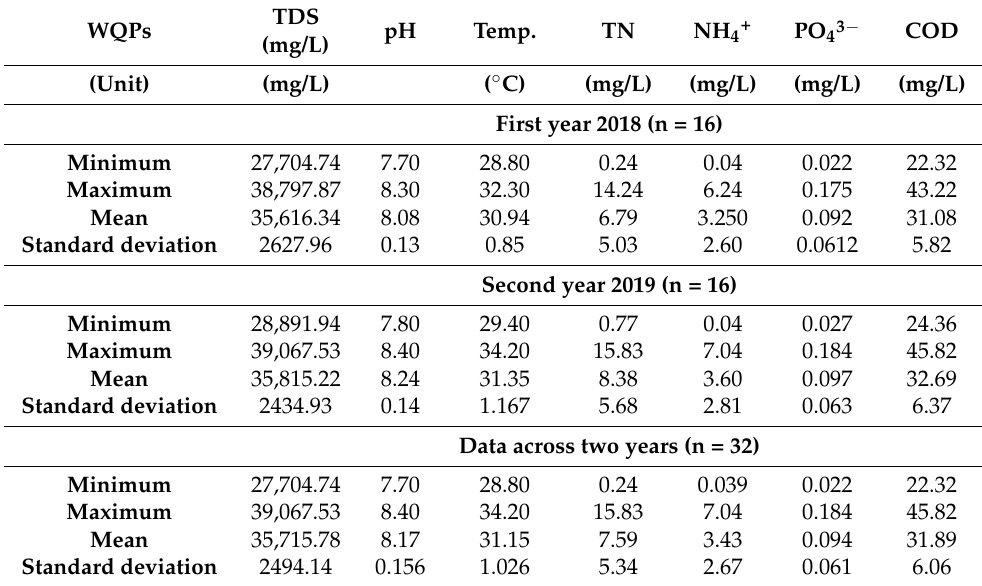
Table 2. Statistical analysis of WQPs in Lake Qaroun over two years